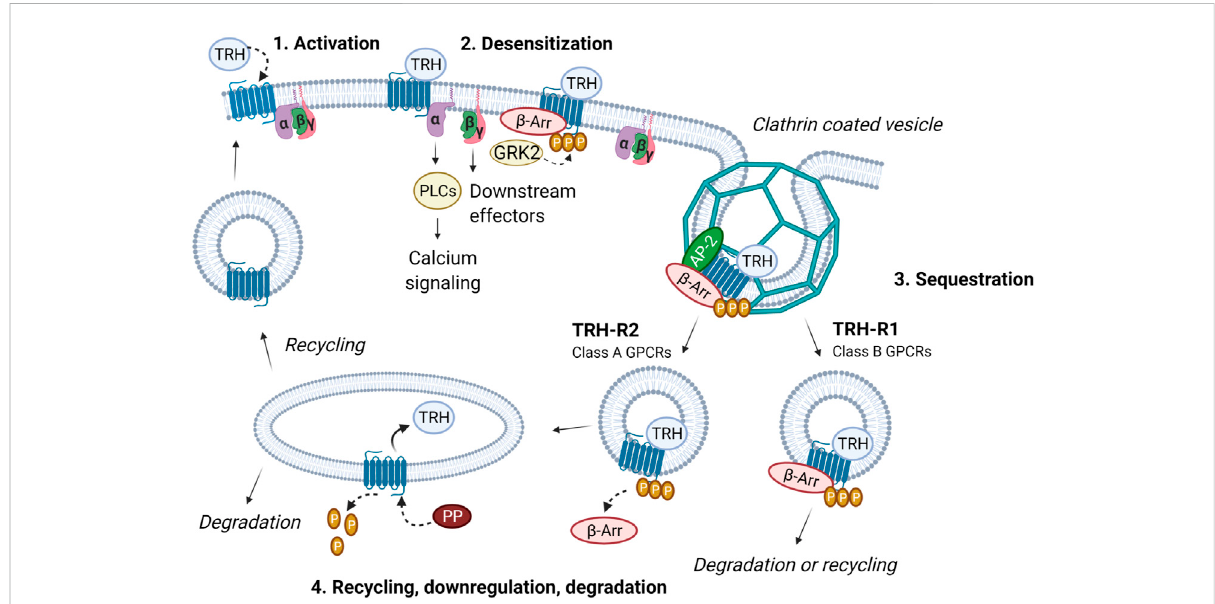
FIGURE 2 Intracellular traf fi cking of TRH receptor subtypes. The activation of TRH-R with TRH results in dissociation of G α and G βγ and an increase in intracellular calcium. Receptor is then desensitized through phosphorylation by GRK2 and β -arrestin binding. In this way, coupling between the receptor, G protein and effector is abolished and signaling terminated. β -Arrestin functions as an adaptor protein which recruits proteins from the endocyticmachinery(i.e.,clathrin,AP-2andothers).Subsequently,receptorissequestered via clathrin-coatedvesicles.InternalizedTRH-Rcan then undergo two different processes depending on the receptor subtype and interaction with β -arrestin. TRH-R2, belonging to class A receptors, dissociates from β -arrestin immediately upon internalization. TRH is removed and receptor is dephosphorylated by protein phosphatase (PP). TRH- R2 is then recycled and targeted to the plasma membrane. On the other hand, TRH-R1 which belongs to the class B receptors, forms stable complexes with β -arrestin in endocytic vesicles and can either be degraded or slowly recycled to the plasma membrane. The fi gure was created by